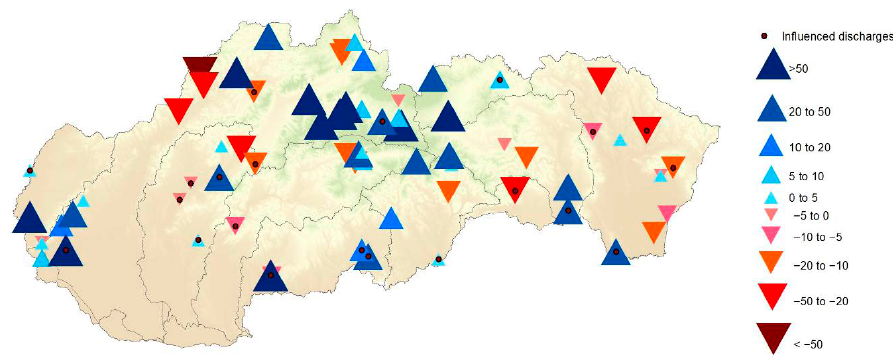
Figure 5. Changes in values of Q 364d from 2001–2015 vs. 1961–2000 (% of increase/decrease).